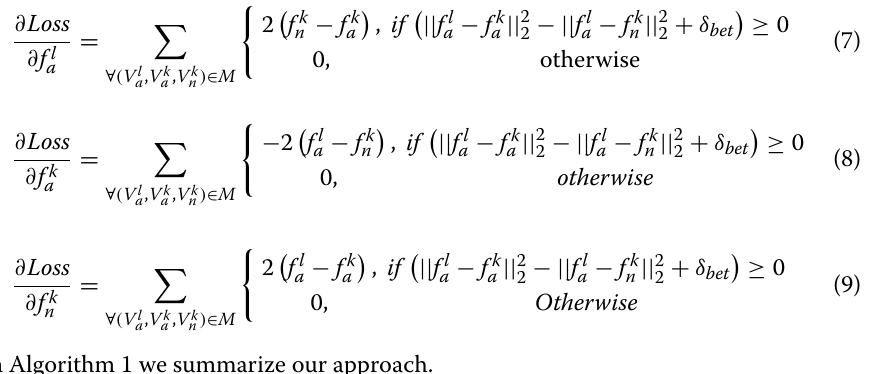
Algorithm 1: MUNEM